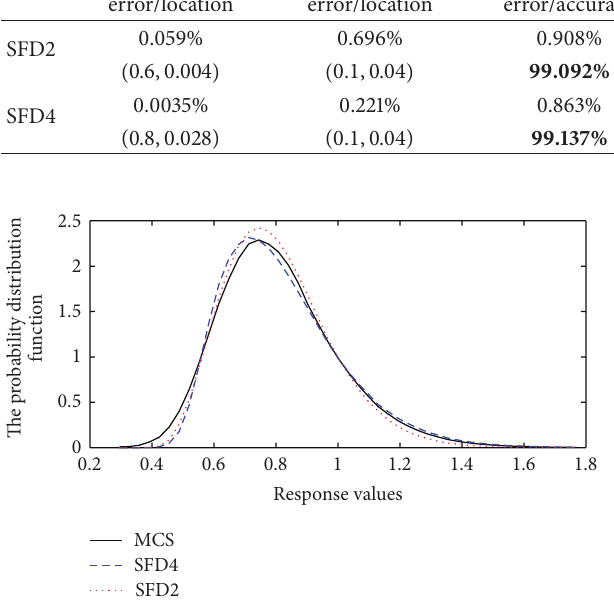
Figure 5: The pdf at point 𝐶 using SFDHC and MCS.